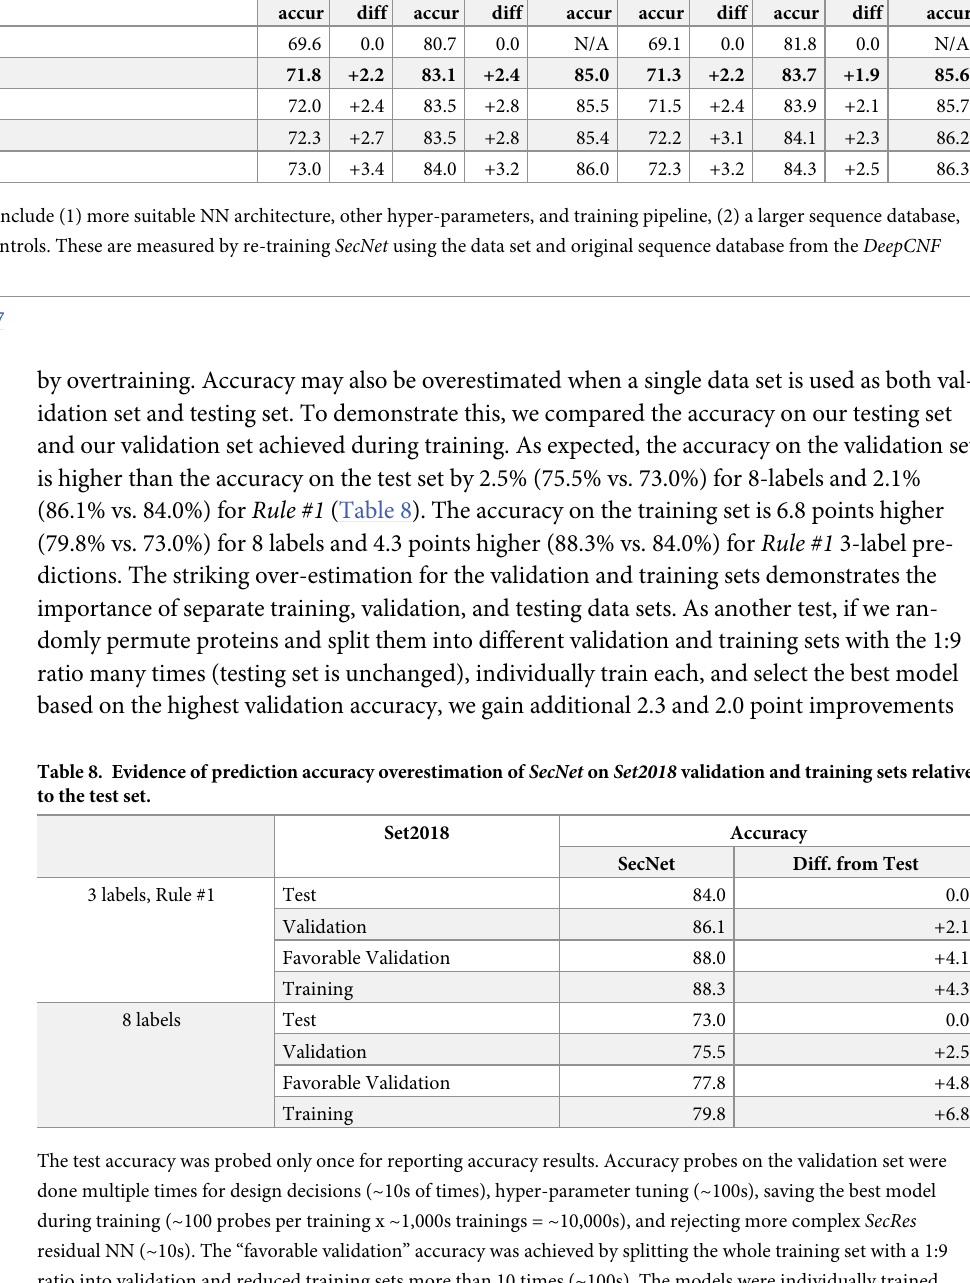
and the validation set with the best accuracy was chosen. The training set accuracy was probed few million times per training (~1,000,000s) during gradient-descent optimization. It is considerably below 100% owing to the regularization technique with 30% dropout. The overestimated numbers underline the importance of having separate test, validation, and training sets and probing the test set only once for reporting unbiased